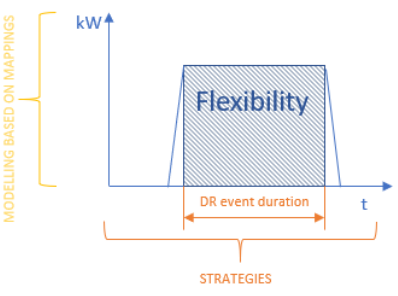
Figure 10. DR event description: available load vs. event duration.